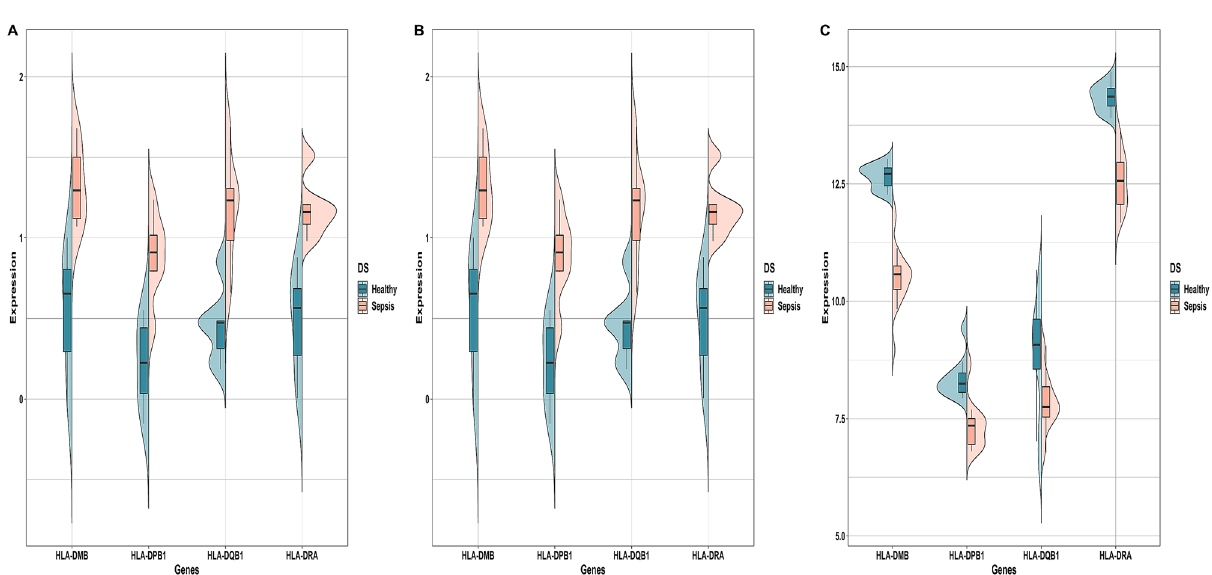
Figure 5. Split violin plots exhibiting expression intensity distribution of 4 hub DEGs (i.e., HLA-DPB1, HLA- DQB1, HLA-DRA, HLA-DMB) in (A) elder, (B) adult, and (C) children age groups. Dark green and brick red colors denote healthy and sepsis samples. The top and bottom of the boxes within the split violin depict the 75th and 25th percentile of the distribution. The horizontal lines within the boxes signify the median values. Axis endpoints are labeled by the minimum and maximum values,